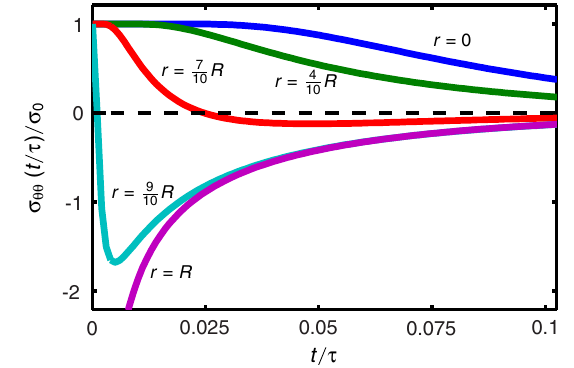
‘‘COOLING BY HEATING’’—DEMONSTRATING THE . .